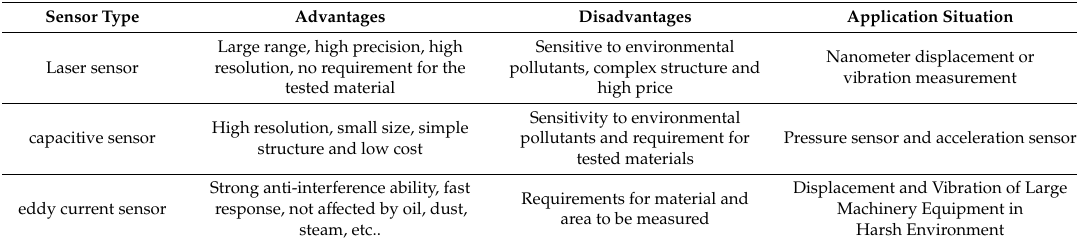
Table 1. Non-contact displacement sensor